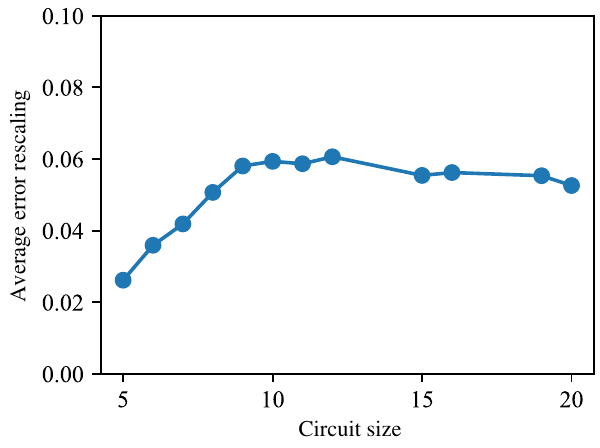
FIG. 8. Average error rescaling factor for various circuit sizes. The circuit size is equal to the number of qubits and layers